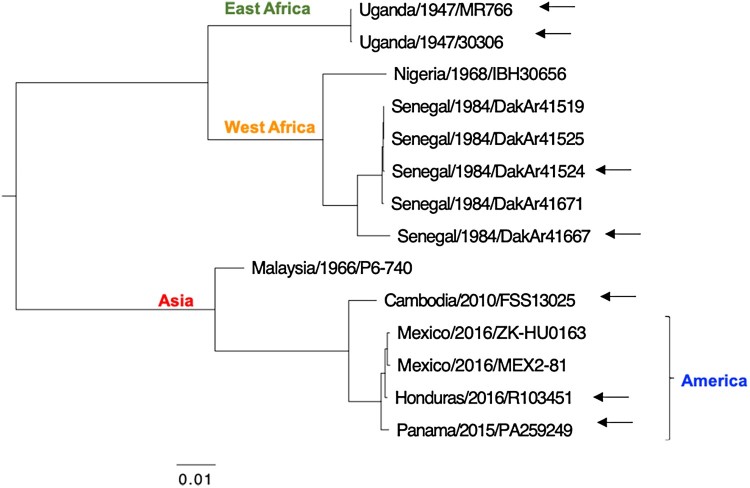
Phylogenetic analysis. Maximum-likelihood phylogeny of ZIKV strains from the WRCEVA supported the groupings into the East Africa, West Africa, and Asian lineages, the latter containing strains from the recent epidemic. Arrows point to the ZIKVs chosen for genetic diversity analysis.